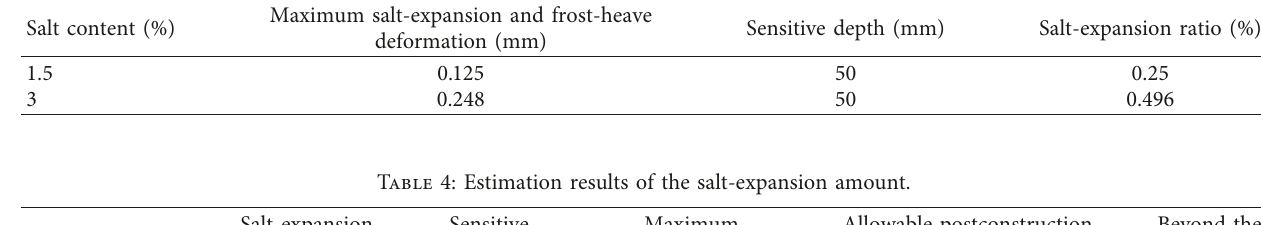
Table 3: Salt-expansion rate of saline soil with different salt contents.